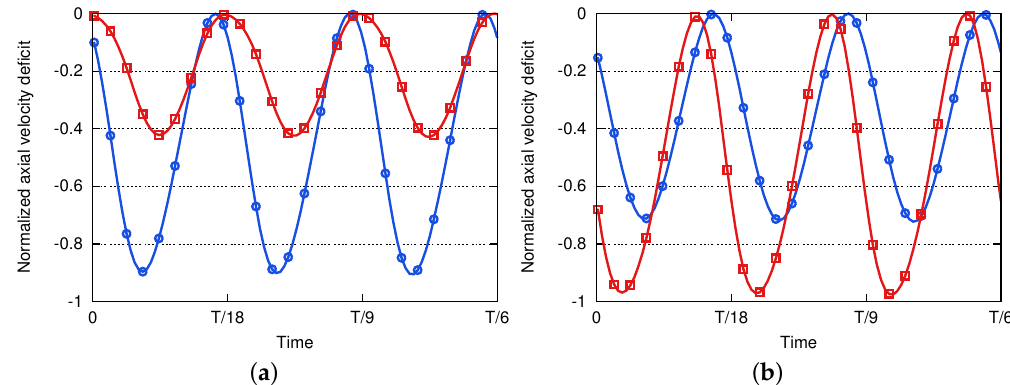
Figure 14. Temporal evolution of the normalized axial velocity deficit upstream of the OGVs at 95% of channel height at two different azimuthal positions: axisymmetric case in blue line marked with circles and asymmetric case in red line marked with squares. ( a ) θ = θ 1 ; ( b ) θ = θ 2